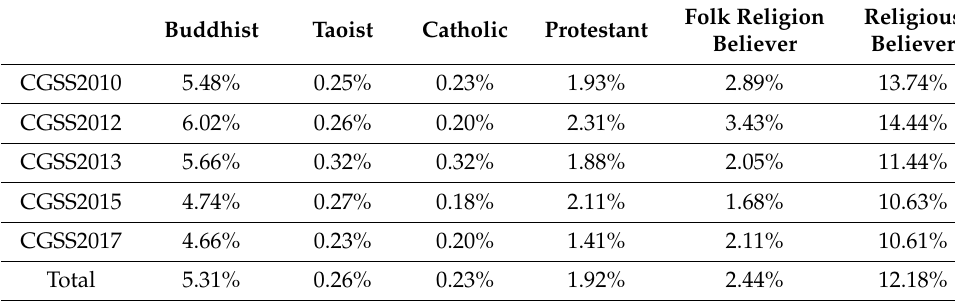
Table 1. Descriptive statistics of the proportion of each religious